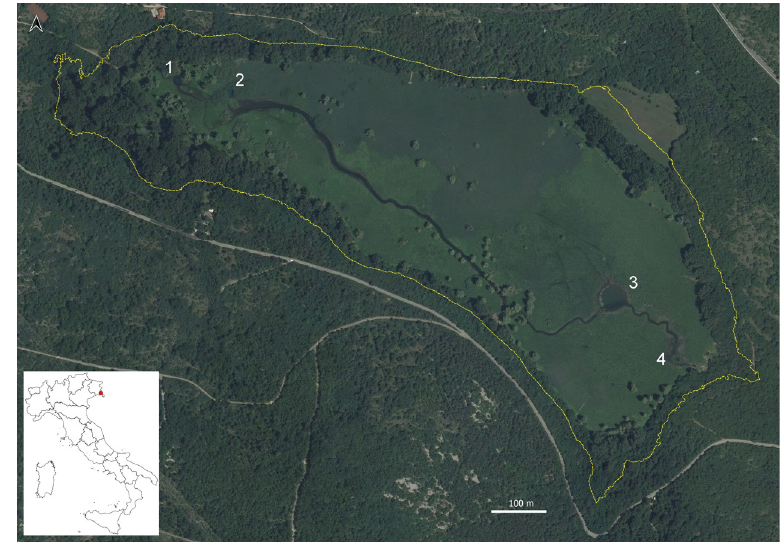
Figure 1. Study area at low-water period (2011 orthophoto, from IRDAT FVG). The springs of the karst Lake Doberdò are con- centrated in the West sector of the basin, with the two major spring pools visible to the NW (1-2); a stream flows through the polje, with a large pool (3) at the confluence of various spring-fed channels located in the central-eastern sector of the basin; the stream disappears in the swallow hole pools in the East sector (4: main swallow hole pool). The dashed yellow line corresponds to the sea- sonal highest water